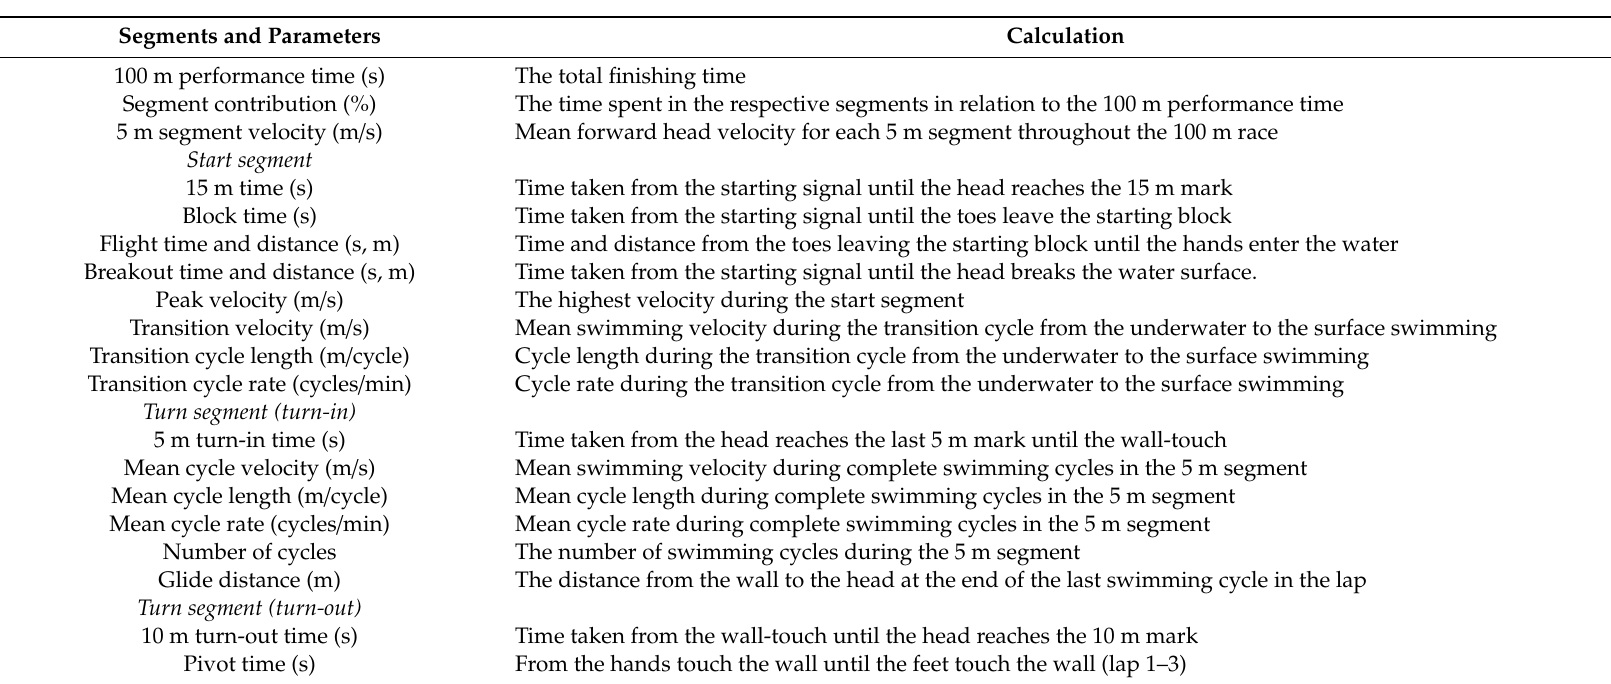
Table 1. Definition of kinematical variables chosen for